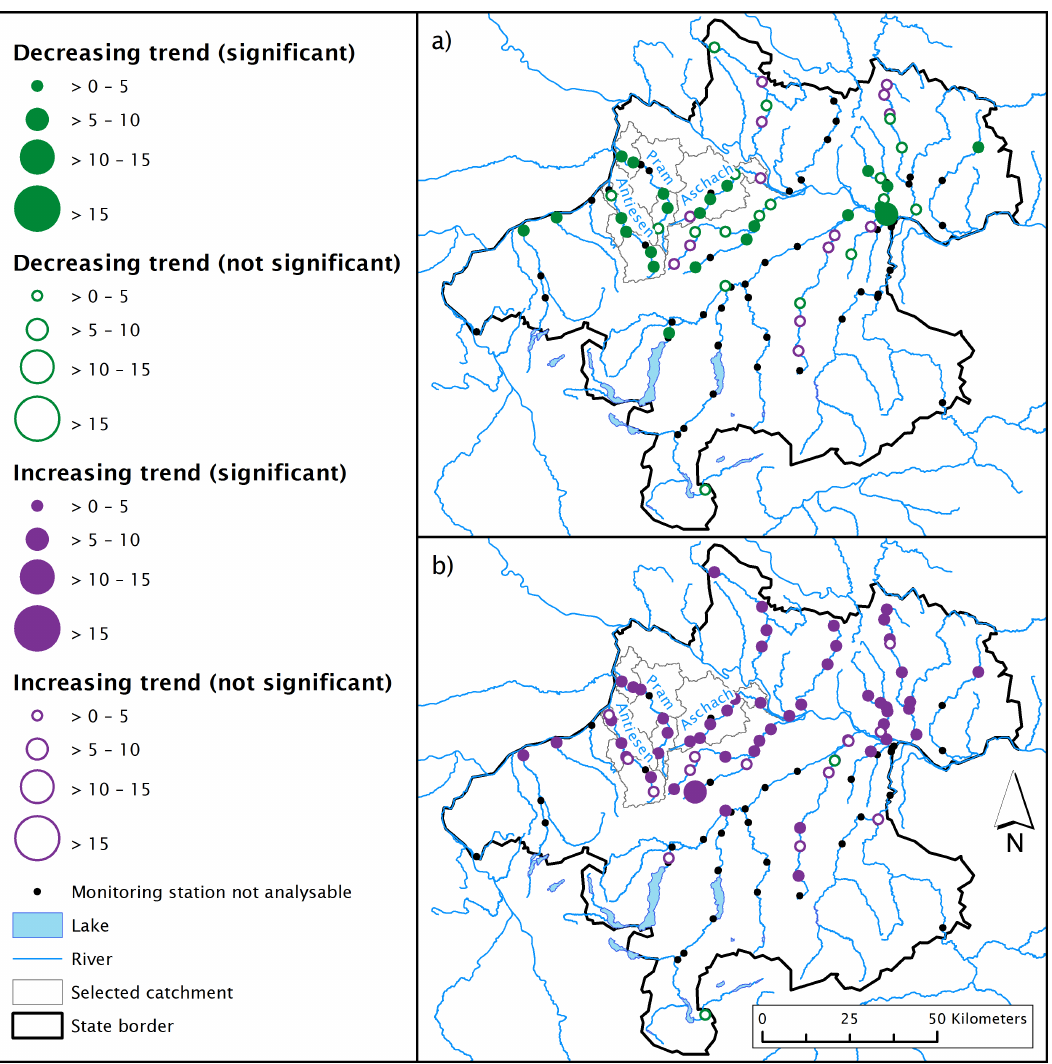
Figure 10. Trends of particulate phosphorus concentration (µg PP L − 1 year − 1 ) in surface waters in Upper Austria for the following two periods: ( a ) 1990–2000; and ( b )